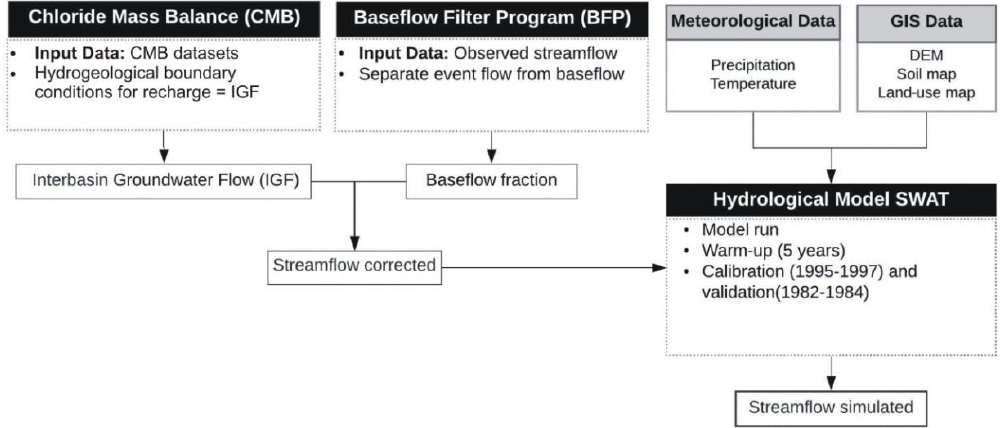
Figure 3. Flow diagram for the coupled Soil and Water Assessment Tool (SWAT) model and chloride mass balance (CMB) method application to model streamflow of hydrological basins subjected to interbasin groundwater flow (IGF).